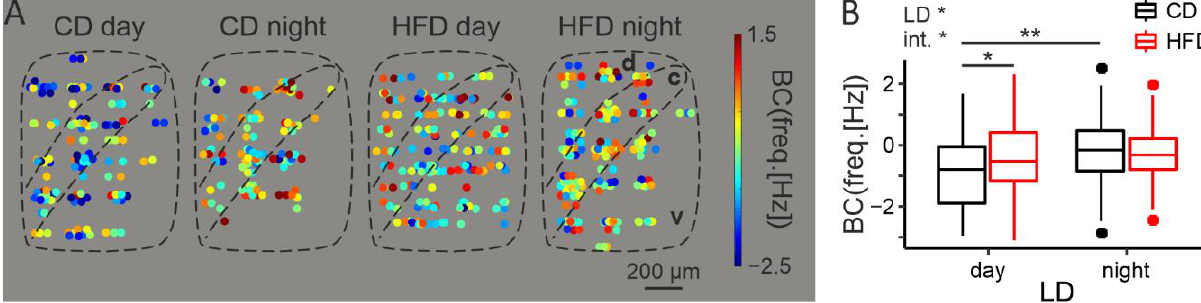
Figure 3. HFD increases midday electrical activity of the DMH. ( A ). Heatmaps illustrating spatial distribution of the recorded neurons and their firing frequency with color-coding. Data points from the same location (recording electrode) were scattered around it. d — dorsal part of the DMH, c — compact part of the DMH, v — ventral part of the DMH. ( B ). Comparison of the spontaneous neuronal activity between cells obtained from animals fed either control (CD) or high-fat diet (HFD), either during the day or at night (LD — light/dark; diet: F1,6 = 4, p = 0.096; LD: F1,5 = 14.14, p = 0.011, diet day: F1,4 = 1.87, p = 0.24; interaction: F1,5 = 6.61, p = 0.047). BC — Box – Cox transformed values; λ = 0.26. * p < 0.05, ** p < 0.01. Box-and-whisker plots present the median value, the interquartile range (IQR; box) and the minimum-to-maximum range of values, not exceeding 1.5 * IQR (whiskers). Data points outside this range are plotted individually as outliers.